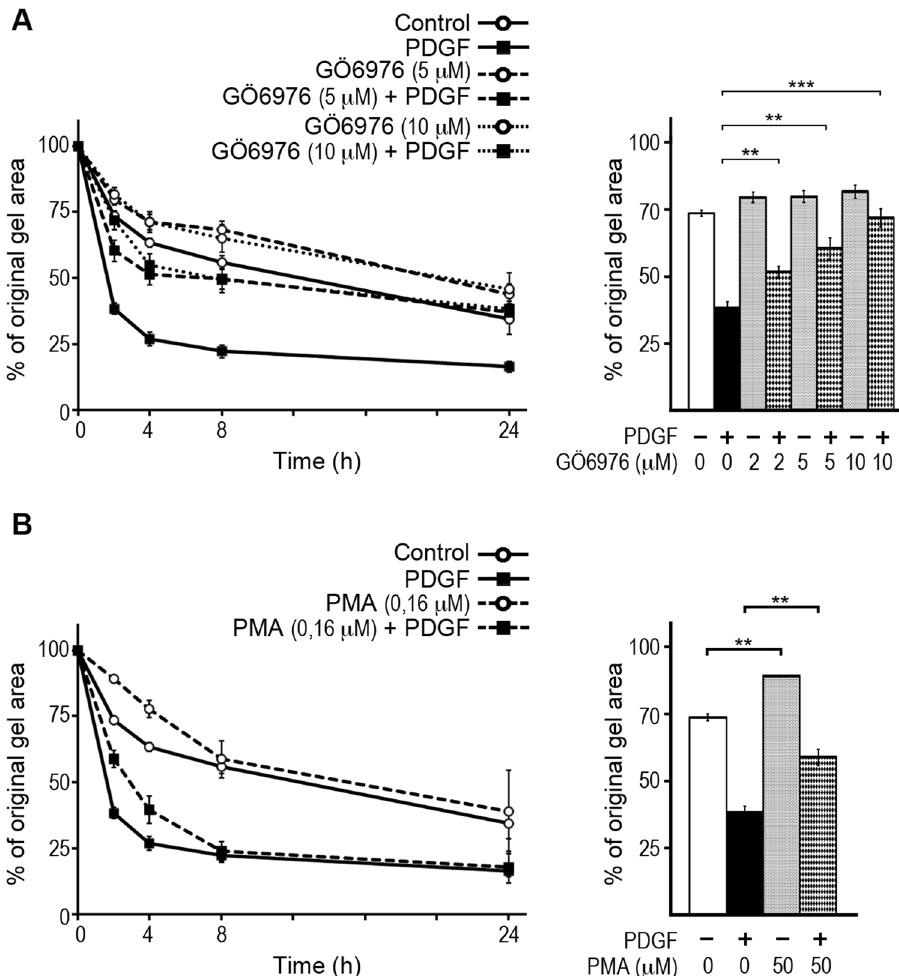
Figure 6. Inhibition of PKC inhibits PDGF-enhanced contraction of collagen gels. BJ fibroblast cells were treated with the PKC inhibitor GÖ6976 ( A ), or the PKC activator PMA ( B ) and used in collagen gel contraction in presence and absence of 20 ng/mL PDGF-BB. In both panels, the graph to the left presents the course of contraction during 24 h, while the bar chart to the right side presents the contraction after 2 h for statistical analysis. In both panels shown data are averaged from three individual experiments. ( ** ) refers to p < 0.01 and ( *** ) refers to p < 0.001. Error bars are